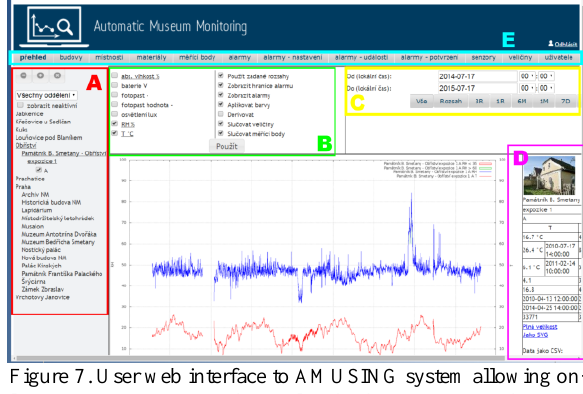
Figure 7. User web interface to AMUSING system allowing on- line access to sensors and complex database queries and control and monitoring of network of sensors. The panel A enables user to select location to be inspected on hierarchy town – building – floor – room – sensor, to choose variables to be plotted in graphs below (B), to determine time interval of interest (C). In addition to plot, also summary information of object and sensors is displayed (D). Other functions and services are accessible on panel